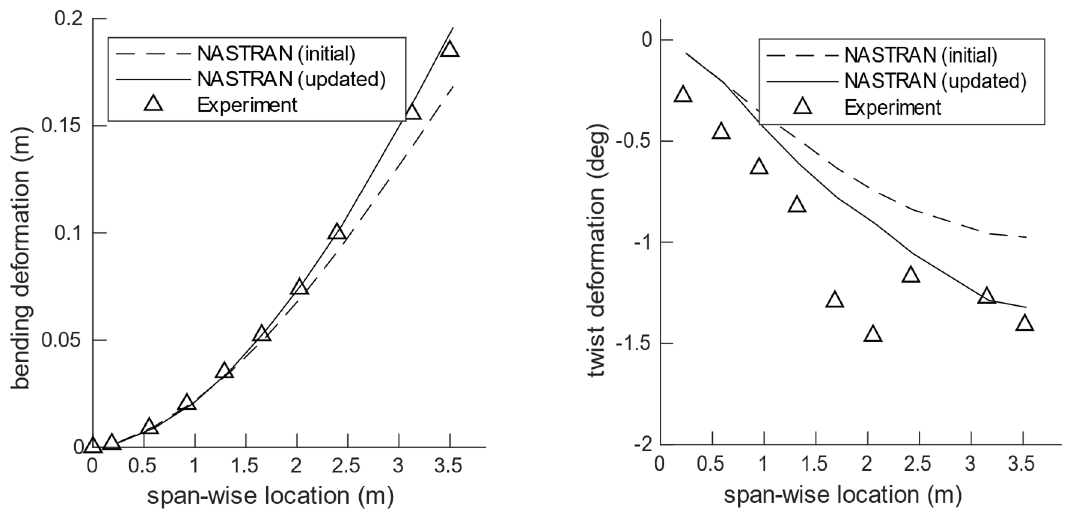
Figure 11. Displacement ( left ) and twist ( right ) comparing the initial FE model, updated FE model and static test experiments for the reference wing.